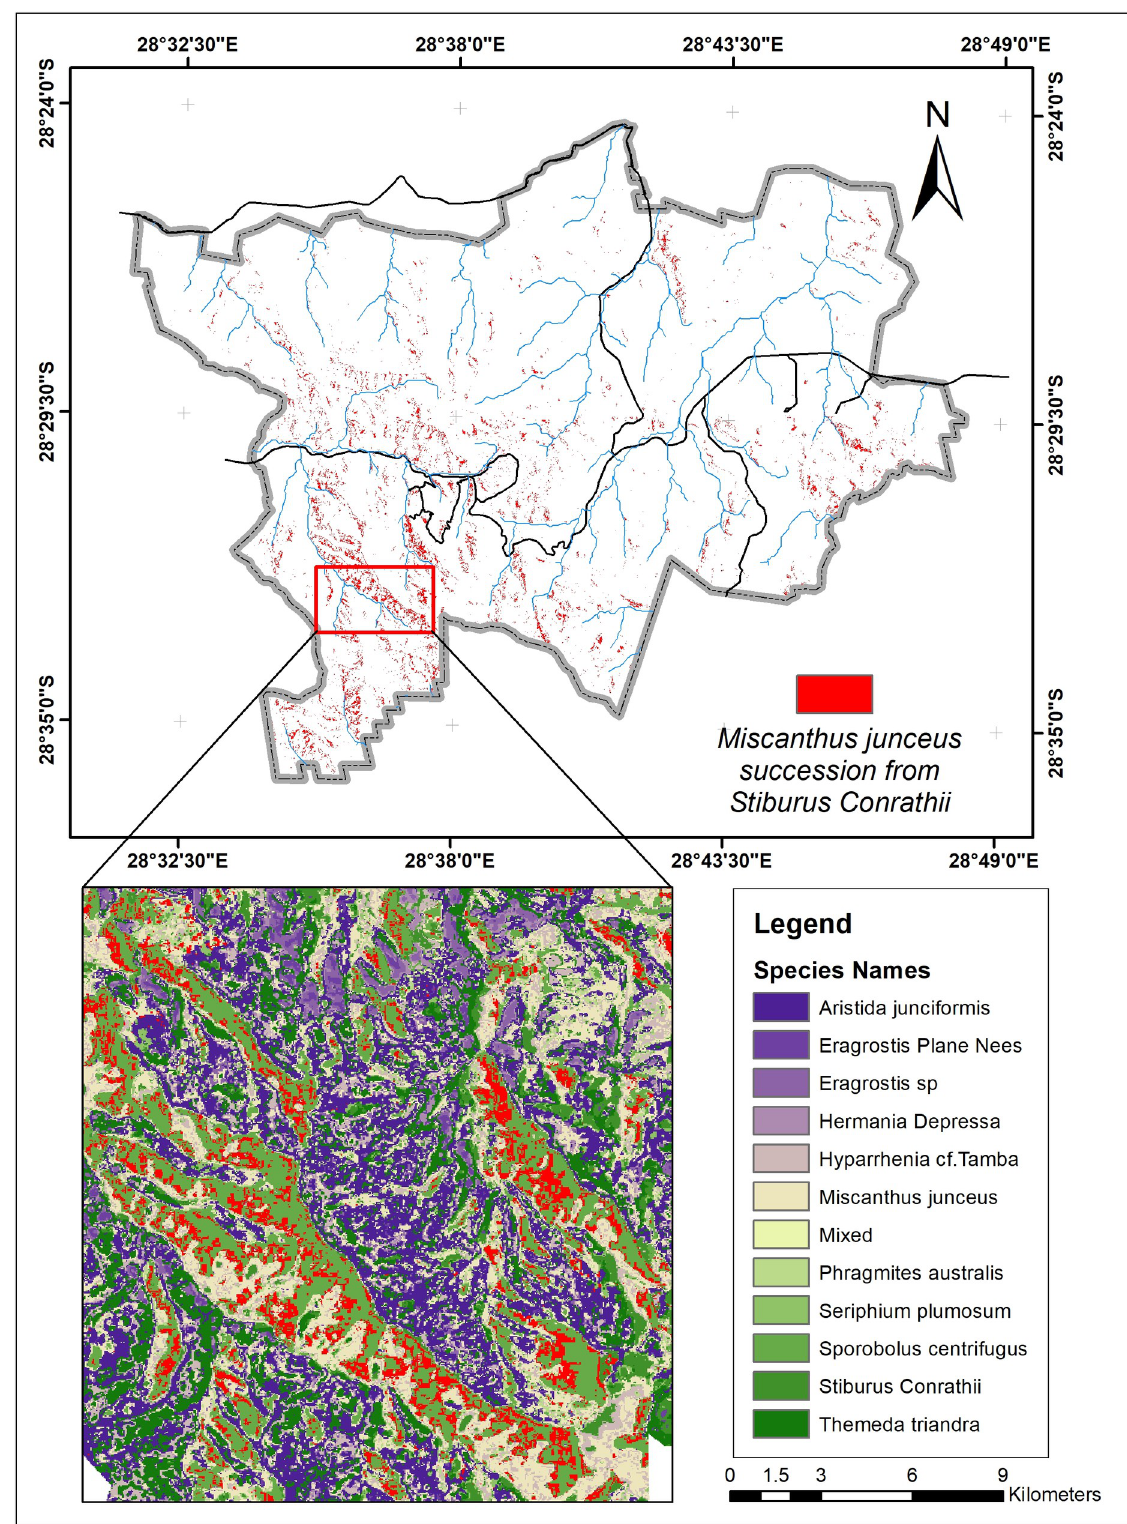
Fig 9. Areas where M . junceus succeeded from S . Conrathii